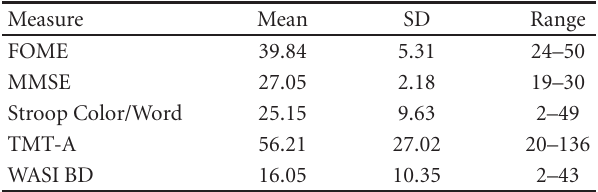
Table 2: Descriptive statistics for cognitive measures.